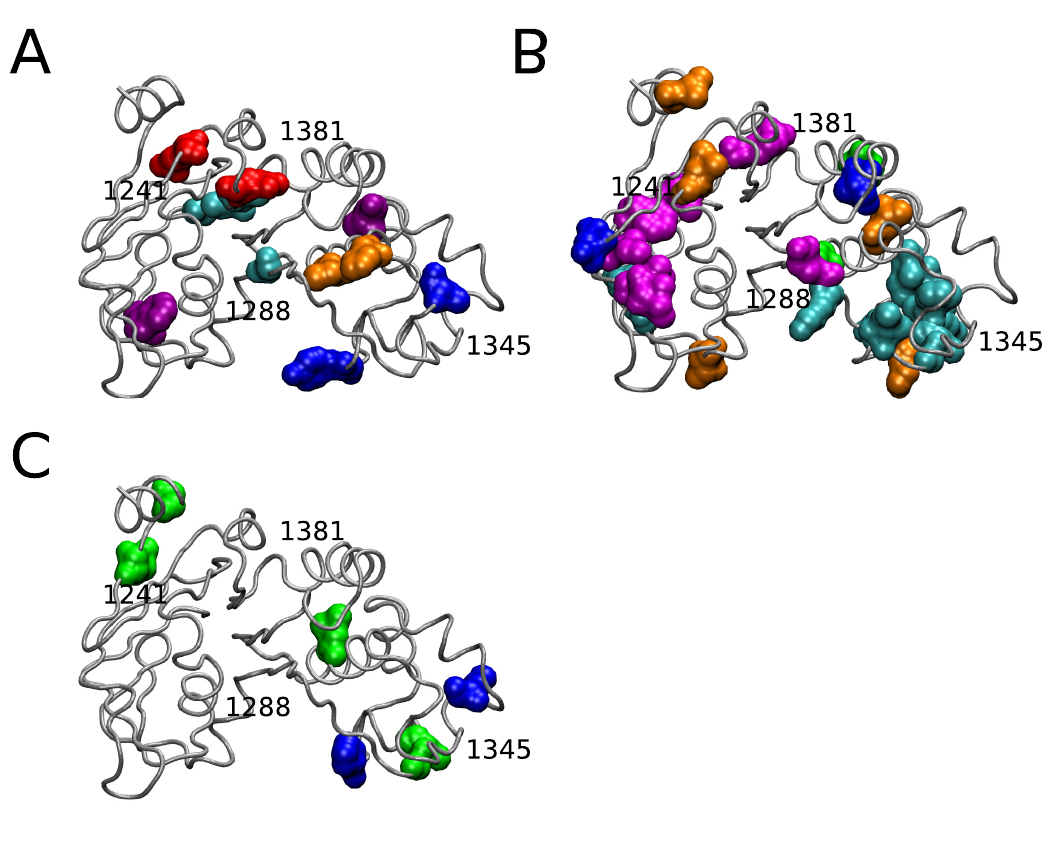
Fig 7. Visualization of BIS results for D1270N, N1303T, and S1251T analyses. (A) Cryo-EM Structure of NBD2 residues 1207– 1436 (PDB:5UAK) with BIS predicted co-evolved residues for D1270N with two clusters visualized in D = 0 ((cluster 1 = red; p- value = 0.00073), (cluster 3 = purple; p-value = 0.00075)), and three clusters in D = 1 ((cluster 2 = cyan; p-value = 0.050),(cluster 5 = orange; p-value = 0.0476), (cluster 6 = blue; p-value = 0.00014)) (B) co-evolved residues for N1303T with five clusters visualized in D = 1 ((cluster 1 = cyan; p-value = 0.0179), (cluster 3 = orange; p-value = 0.0167), (cluster 4 = magenta; p- value = 0.0313), (cluster 5 = blue; p-value = 0.0119), (cluster 6 = green; p-value = 0.0116)). (C) co-evolved residues for S1251T with two clusters visualized in D = 1 ((cluster 1 = blue; p-value = 0.00413), (cluster 2 = green; p-value = 5.0612E-08)) Amino acid numbers for reference. Structures visualized using VMD [55] and rendered using Tachyon [56].